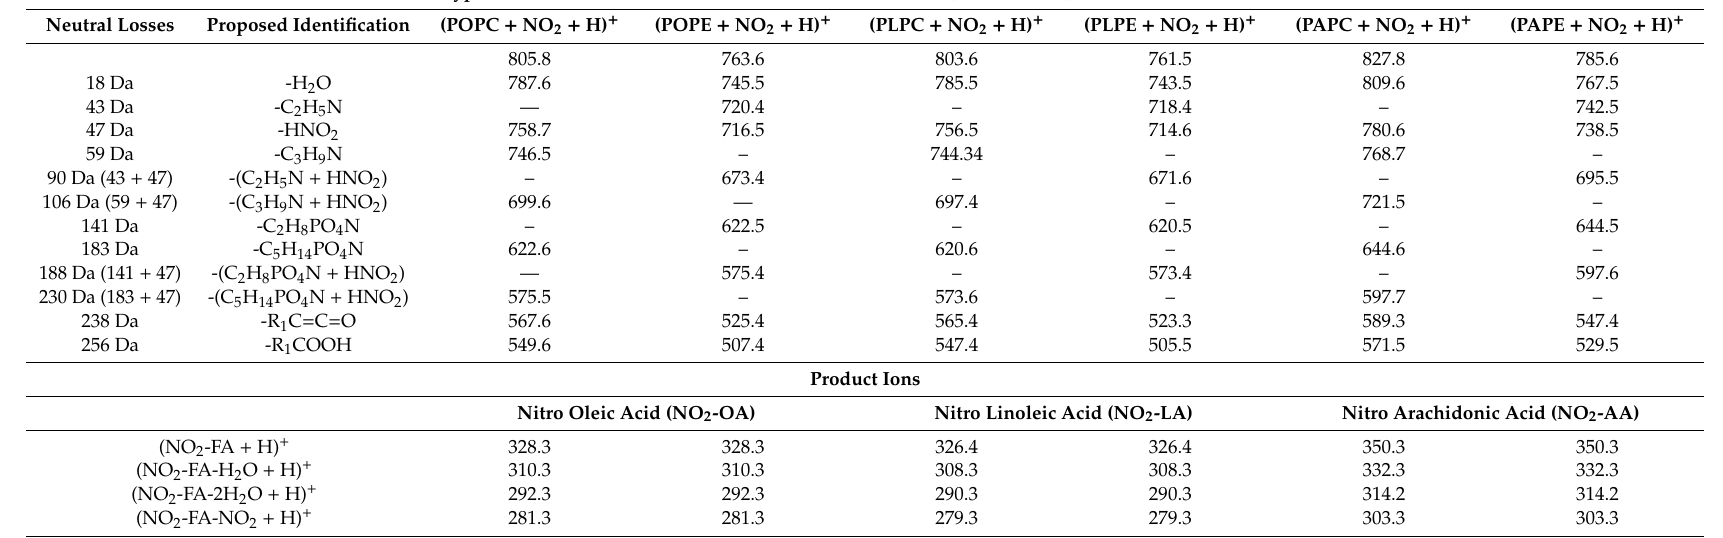
Table 1. Summary of the main fragmentation pathways observed in the higher-energy collision dissociation (HCD)- tandem mass spectrometry (MS / MS) spectra of the (M + H) + ions of nitro (NO 2) phospholipids (PLs) (NO 2 -PLs) formed after the reaction of phosphatidylcholines (PCs) and phosphatidylethanolamines (PEs) with nitronium tetrafluoroborate (NO 2 BF 4 ), with the proposed identification and m / z values: 1-palmitoyl-2-oleoyl- sn -glycero-3-phosphocholine